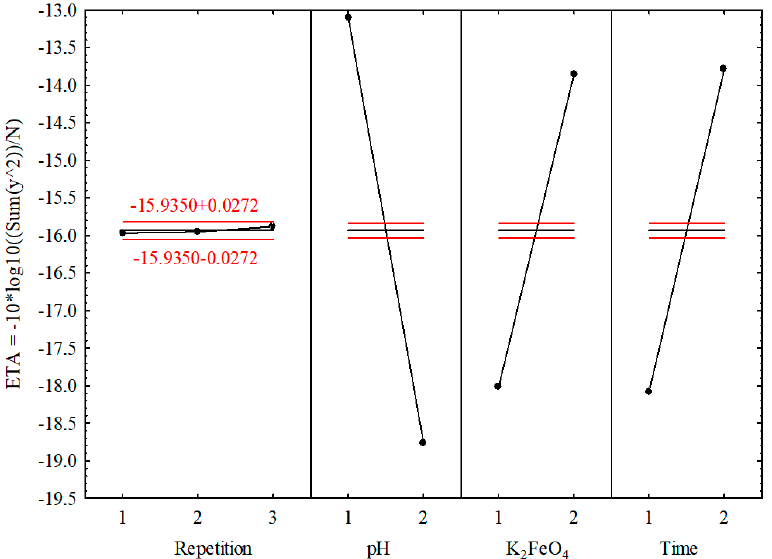
Figure 1. Plot of the ETA ( η ) values versus the input parameter values for tannery wastewater (pH 1 = 3.0, pH 2 = 9.0, K 2 FeO 4 (1) = 0.400 g / L, K 2 FeO 4 (2) = 1.200 g / L, Time(1) = 3.00 min, Time(2) = 9.00 min). The Envifer ® dose was calculated based on pure K 2 FeO 4 . The dotted lines give the mean ± 2 × MS Error).